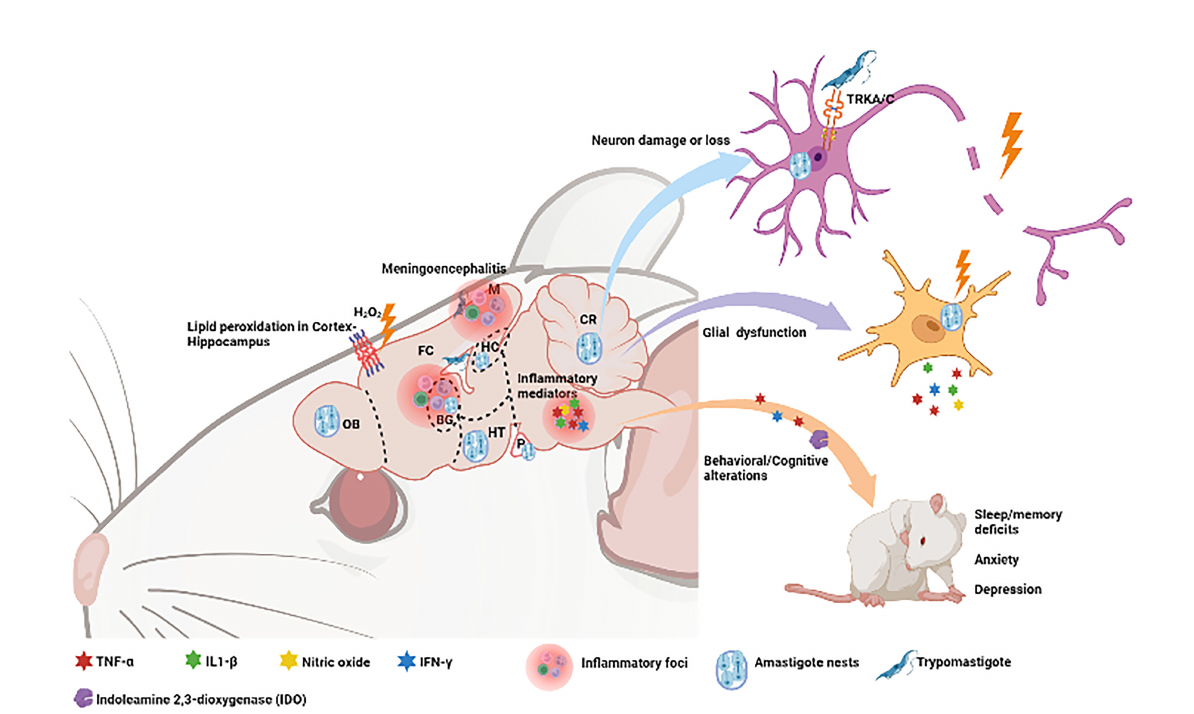
FIGURE 1 Consequences of experimental T. cruzi infection upon the Central Nervous System and respective involved regions. The presence of the parasite in these regions can cause lipid peroxidation as well as neuroin fl ammation with release of in fl ammatory mediators, glial dysfunction and neural damage. Secretion of proin fl ammatory cytokine triggers behavioural and congnitive changes with de fi cits in sleep and memory, as well as symptoms of anxiety and depression. Olfactory Bulb (OB), Frontal Cortex (FC), Meninges (M), Basal Ganglia (BG), Hippocampus (HC), Hypothalamus (HT), Cerebellum (CR). Neurotrophin receptors (TRKA/C). Created with